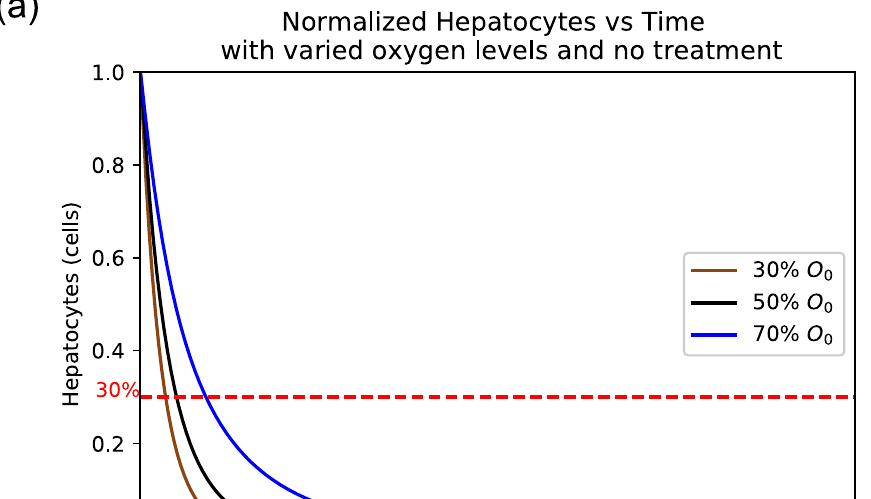
estimated timing of reaching the critical 30% hepatocyte level for irreversible damage for different initial O level. The scatter plot fits the exponent function f ( x ) = ae kx + c , where 2 a = 2.68176(10 − 8 ), k = 0.216333 and c = 0.314243 are estimated using Mathematica. The model also helps estimate a time frame for treatment as shown in Fig 9a. Thus this plot may help